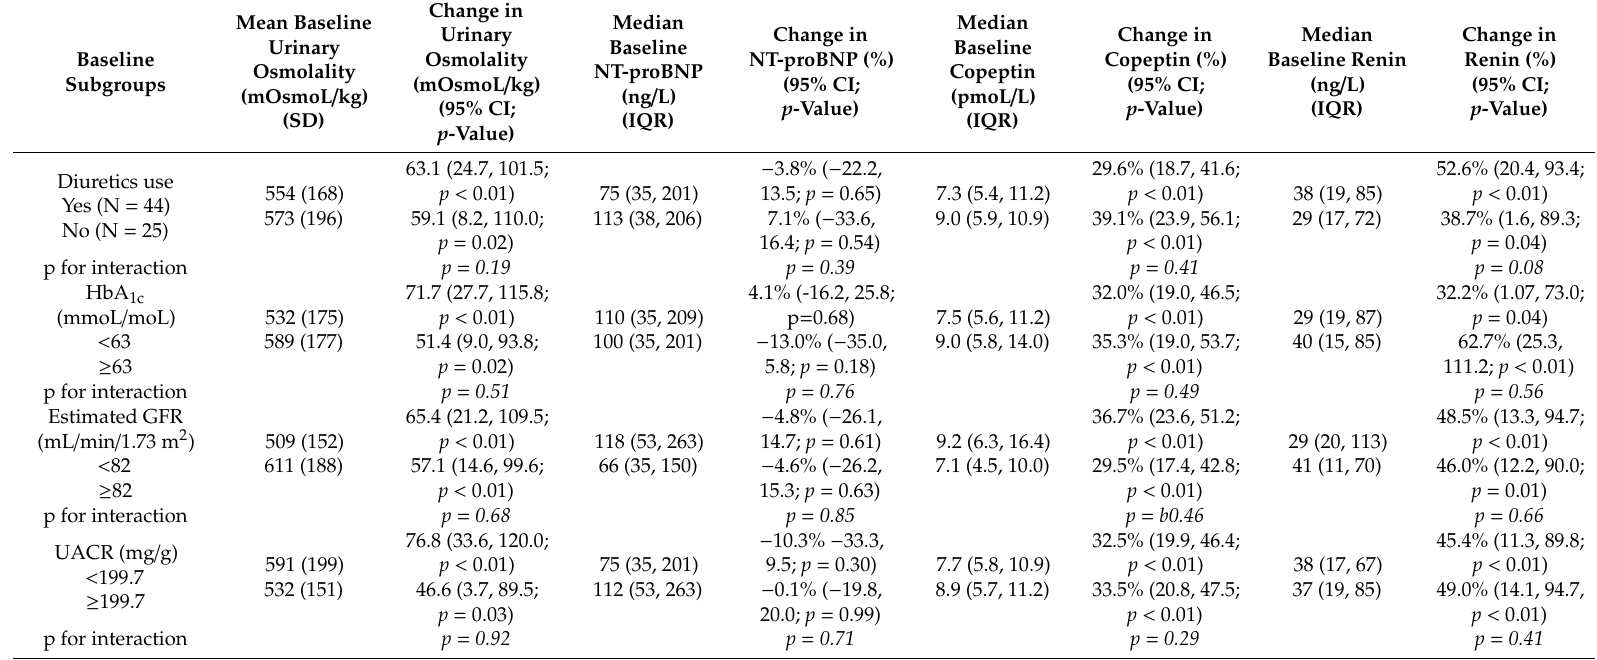
Table 2. Changes in urinary osmolality, NT-proBNP, and copeptin during dapagliflozin therapy versus placebo in various